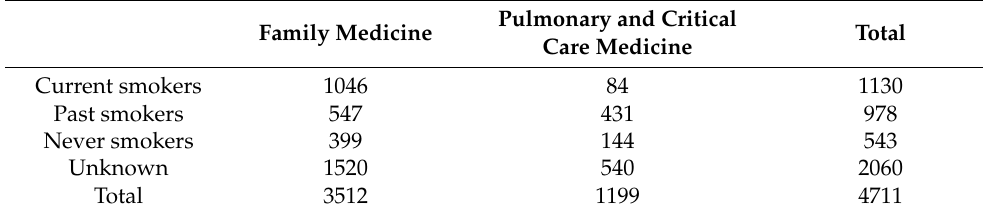
Table 1. Overall summary of SNUH clinical notes data.